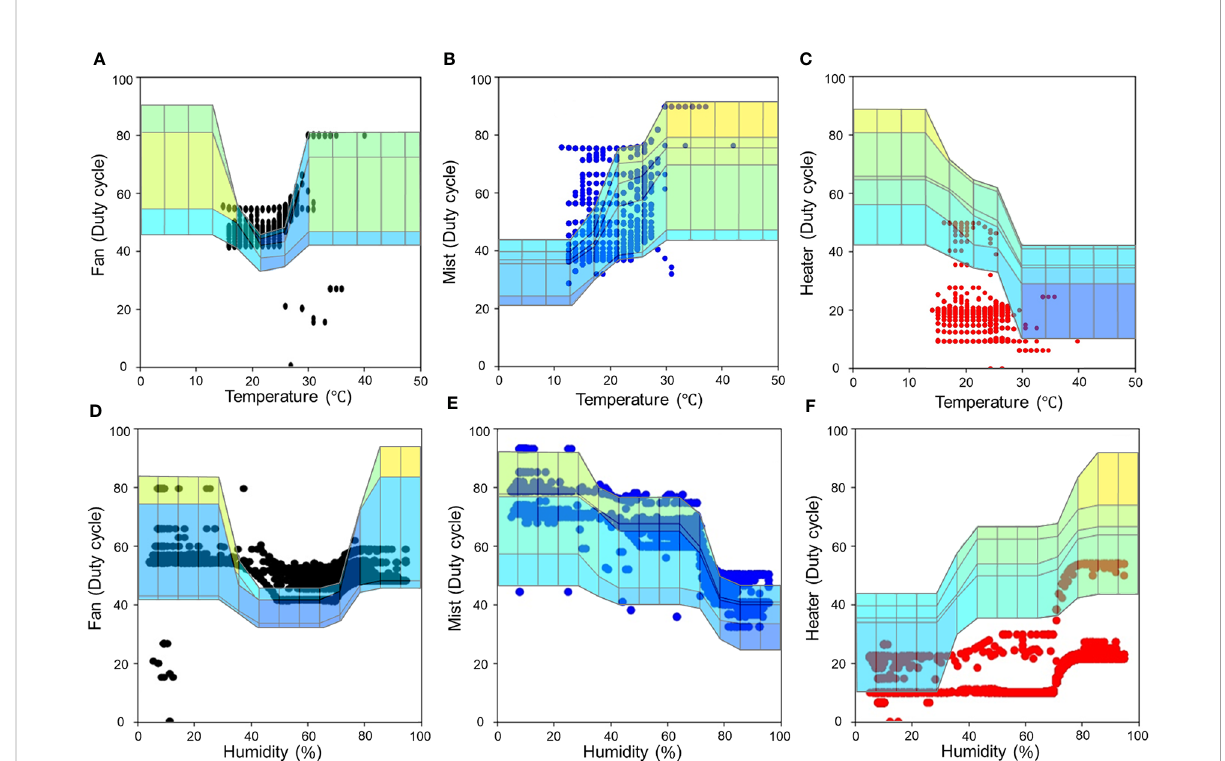
FIGURE 11 Comparison of simulated and actual operational results. (A) Temperature-fan, (B) temperature-mist, (C) temperature-heaters, (D) humidity-fan, (E) humidity-mist, and (F) humidity-heaters.